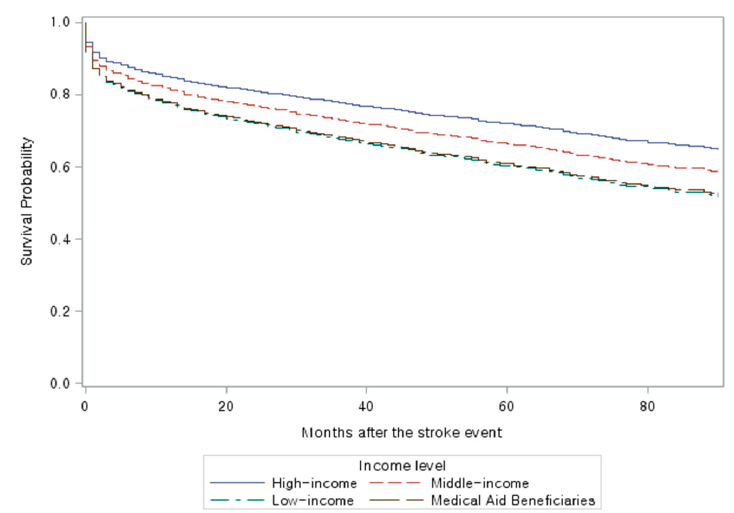
Table 2. Results of Cox Regression Analysis for Insured Employees